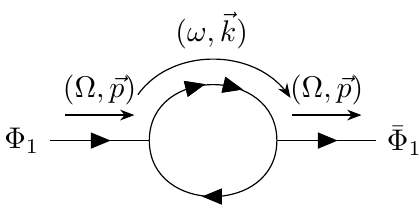
Figure 2. One-loop correction to the self-energy of the (cid:8)